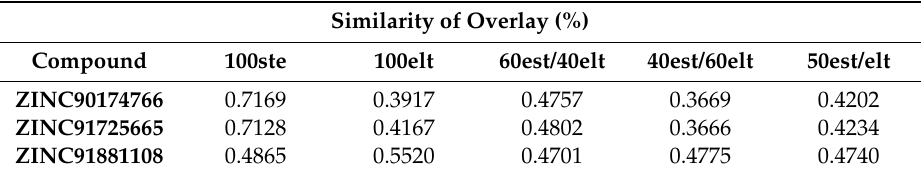
Table 5. Similarity analyses for the molecular overlap of the compounds for 100ste, 100elt, 60est and 40elt, 50est/elt, relative to ponatinib.